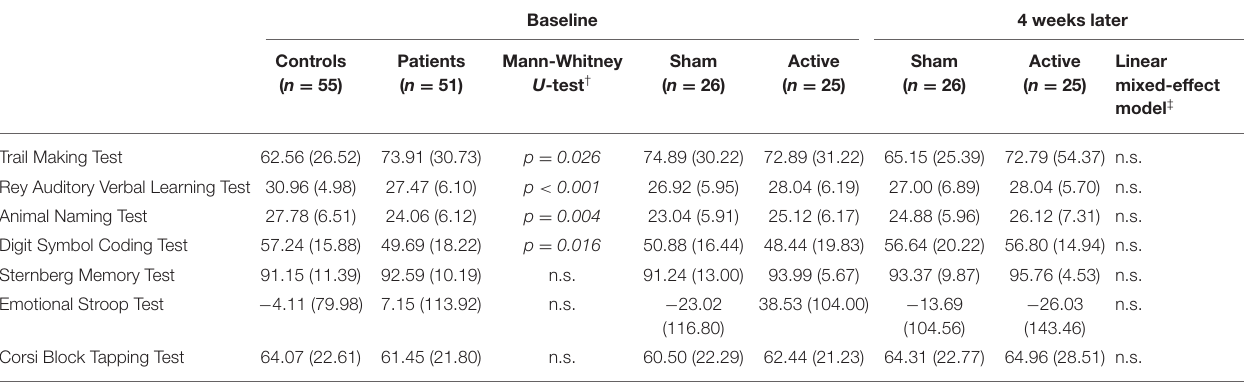
For detailed test information see Table 1 . † Mann-Whitney U-Test for baseline comparison of controls (n = 55) and patients (n = 51), ‡ Linear Mixed-Effect (LME) models with the fixed effect factors treatment allocation (active/sham) and time (baseline/4 weeks later iTBS). Reported are the p-values for each group * time interaction.